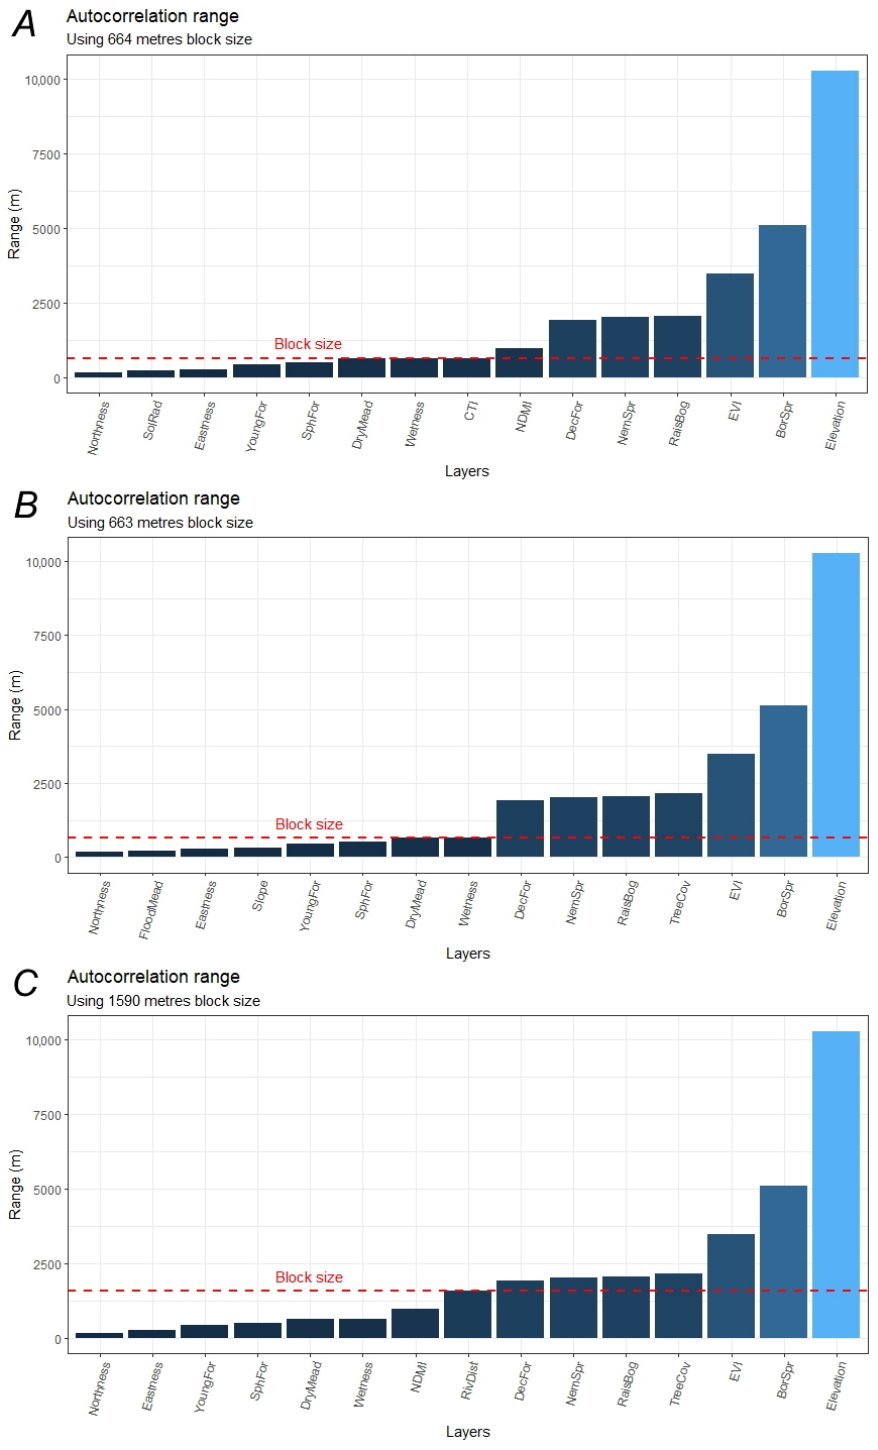
Figure A2. Output graphs from the R package blockCV showing spatial autocorrelation ranges for input predictor variables before fitting 14 food-probability models for the brown bear in the Central Forest State Nature Reserve (West-European Russia) in 2008–2020. Variable subsets for ( A ) plant models, ( B ) insect models, and ( C ) mammal models are shown. For each variable subset, selected block size based on median spatial autocorrelation range across all input predictors is shown.